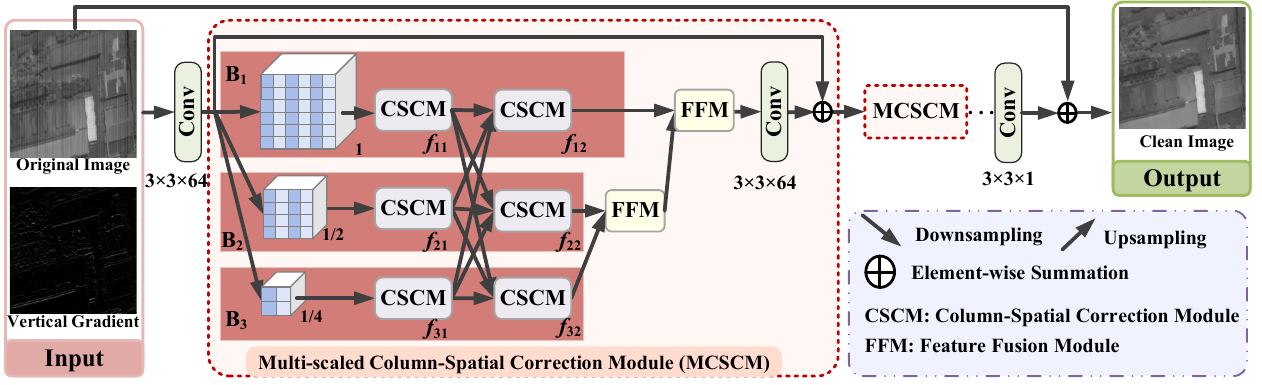
Figure 1. The framework of proposed multi-scaled column-spatial correction network (CSCNet). The main structure of CSCNet is the multiple multi-scaled column-spatial correction module (MCSCM), including the column-spatial correction and feature fusion sub-modules (CSCM and FFM). CSCM corrects the striped image from the perspectives of column difference and global uniformity. Moreover, we use its multi-scale extension to enhance the destriping performance. FFM is adopted to select significant features derived from different modules and